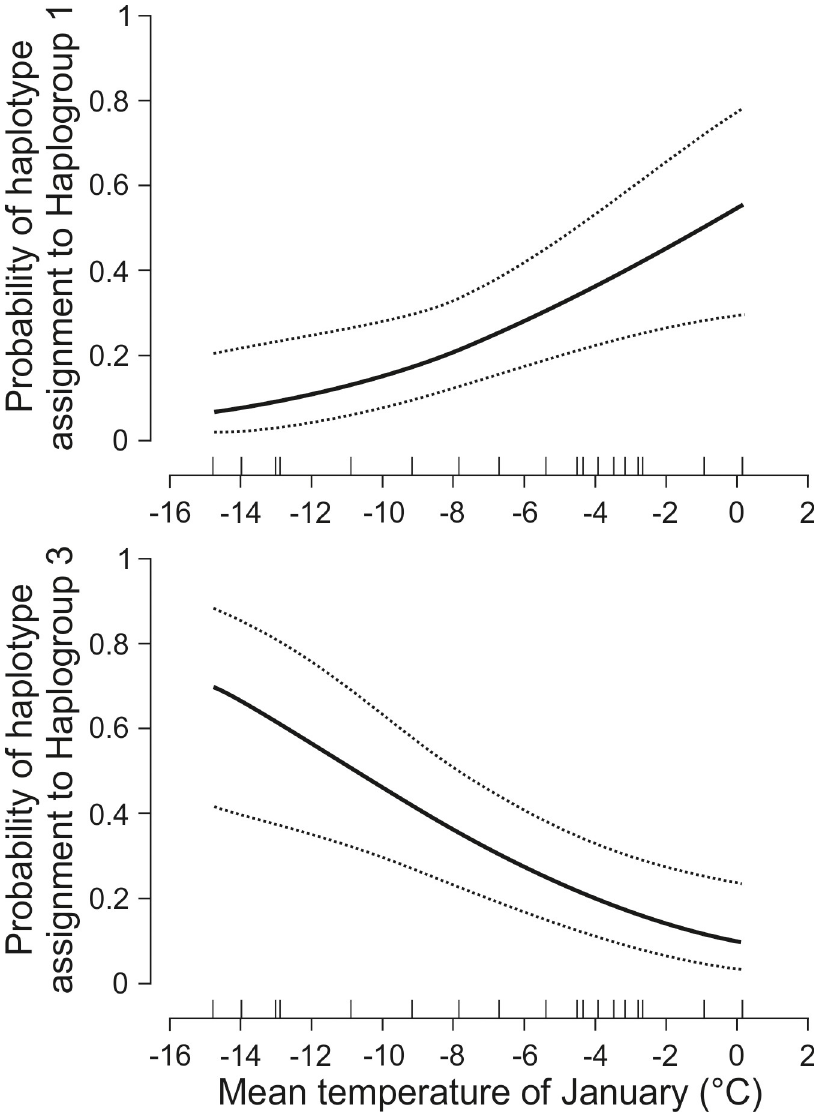
Fig 6. Relationships between mean temperature of January in the year of trapping in 10 studied region in NE Poland and probability of yellow-necked mouse assignment to Haplogroup 1 (upper panel) and Haplogroup 3 (lower panel) − results of the most parsimonious generalized linear mixed models (GLMMs) presented in Table